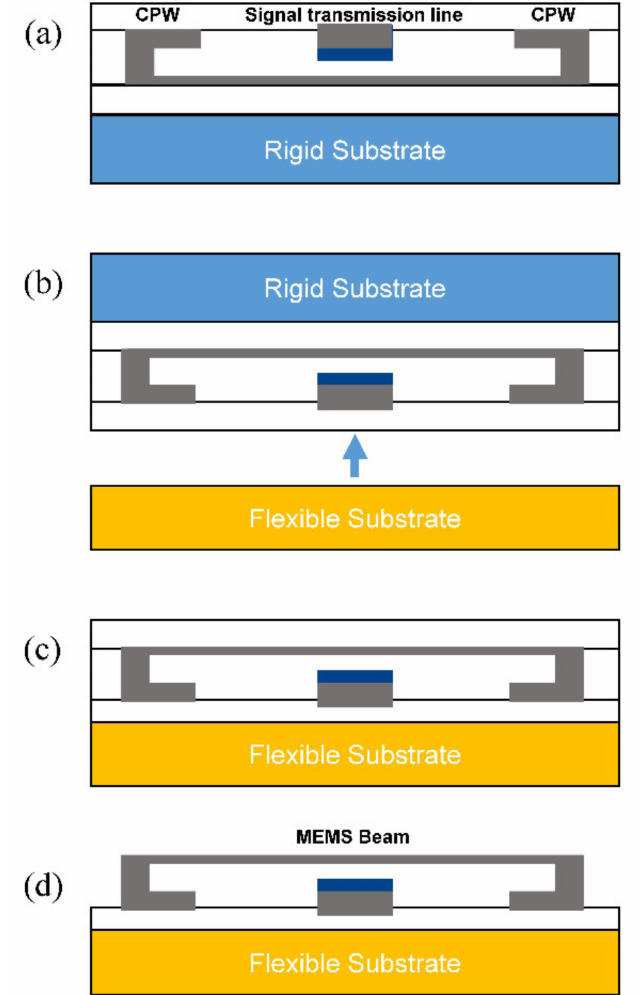
Figure 11. Wafer transfer technology (WTT) process flow for MEMS switch fabrication. ( a ) Reversed process sequence; ( b ) Transfer process; ( c ) Remove the silicon substrate; ( d ) Release the structure. Pang’s team [98–100] proposed a series of flexible RF resonators based on PI